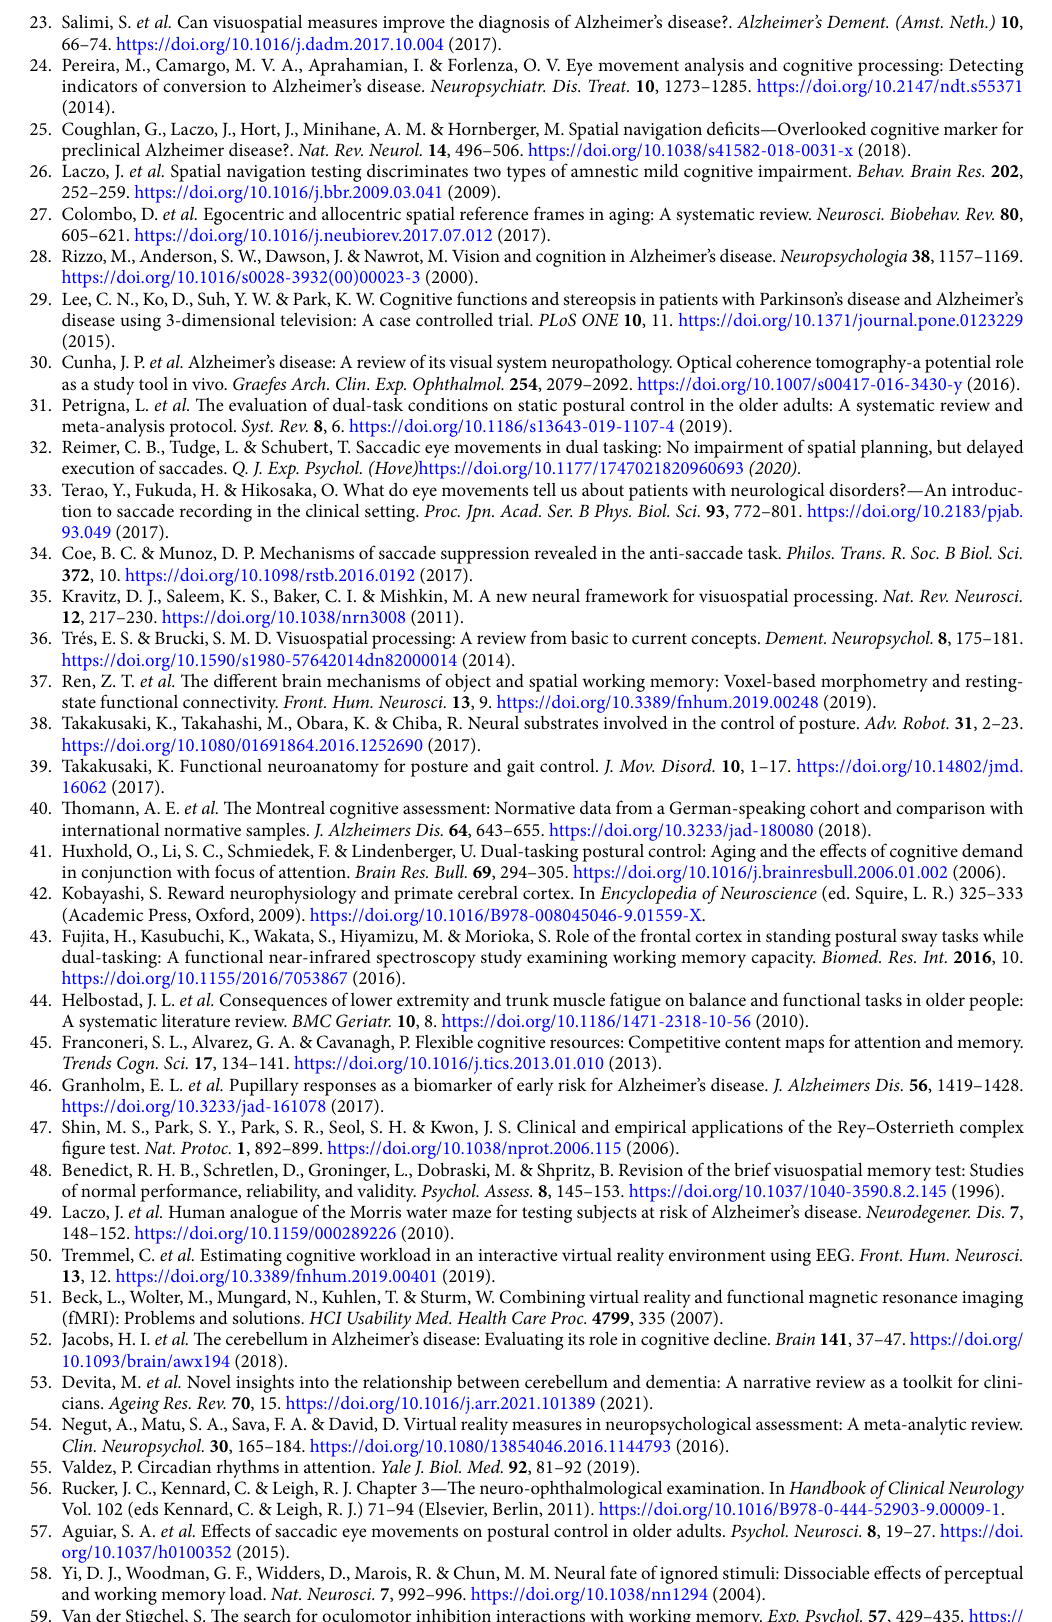
figure test. Nat. Protoc. 1 , 892–899. https:// doi. org/ 10. 1038/ nprot. 2006. 115 (2006). 48. Benedict, R. H. B., Schretlen, D., Groninger, L., Dobraski, M. & Shpritz, B. Revision of the brief visuospatial memory test: